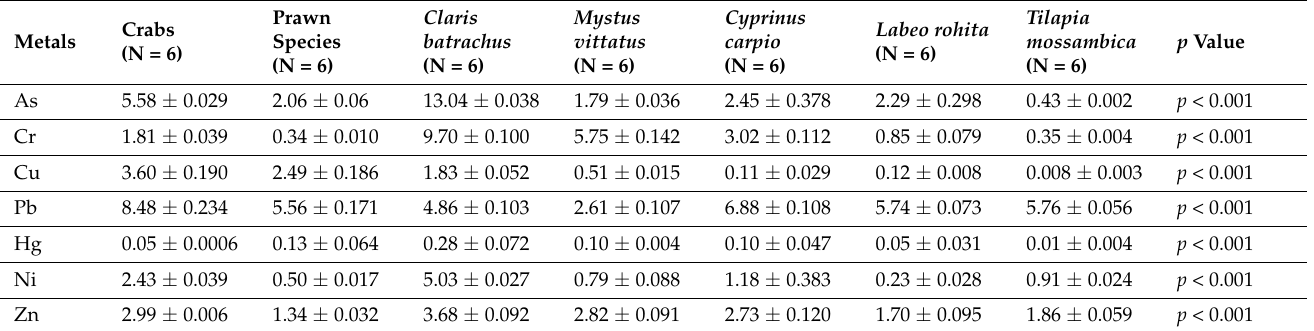
Table 3. Metal accumulation in various prey species of waterbirds, Veeranam Lake, Tamil Nadu, India (Values are mean and SE;